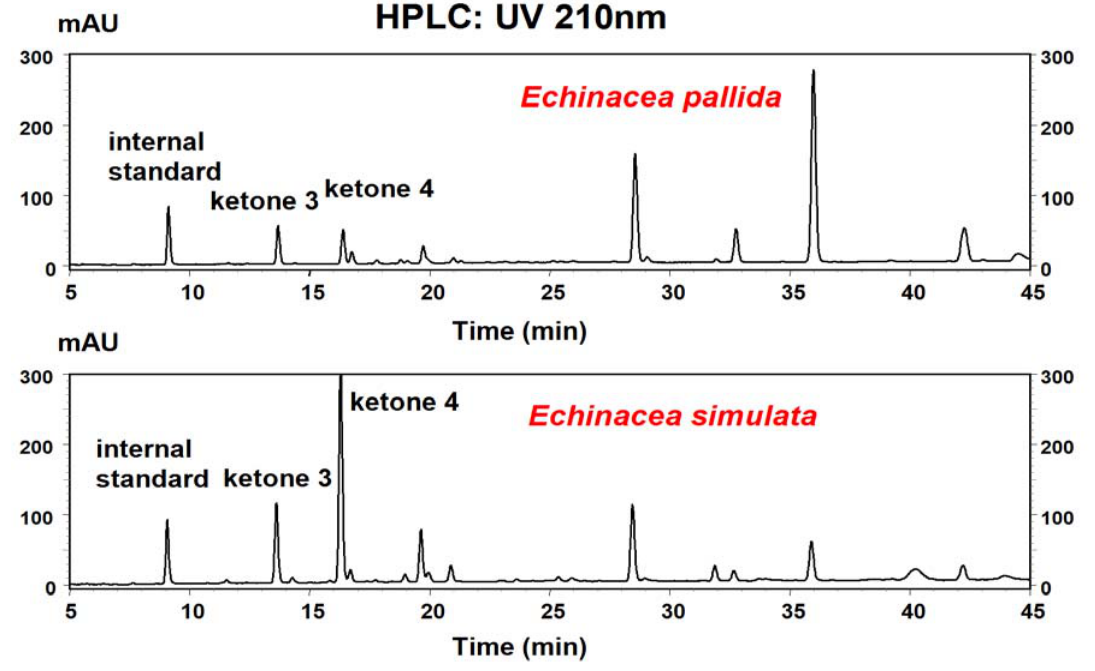
Figure 1. HPLC chromatograms obtained from a 95% ethanolic extracts of two-year-old roots from Echinacea pallida and Echinacea simulata , indicating ketones 3 and 4 .